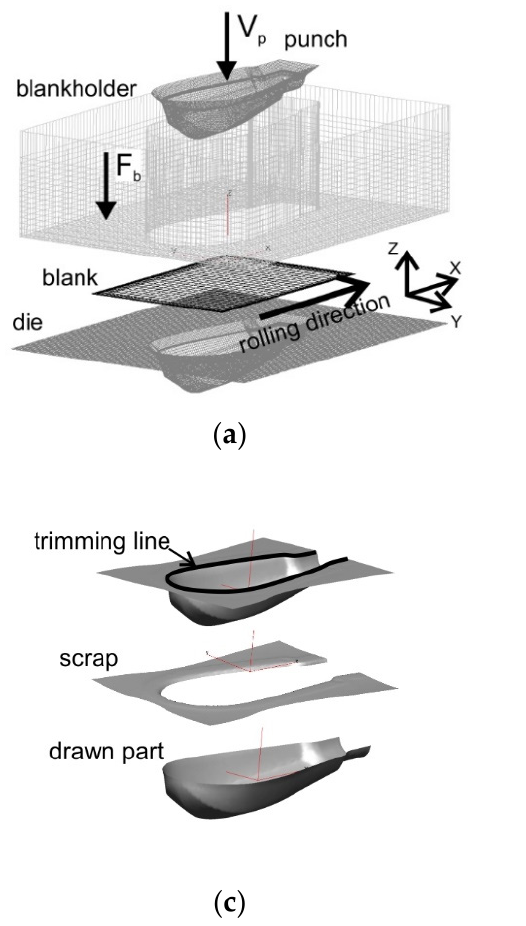
Figure 4. Numerical model of forming handle part (with mesh of finite elements): ( a ) initial forming; ( b ) supplementary forming; ( c ) flange trimming; ( d ) final forming.